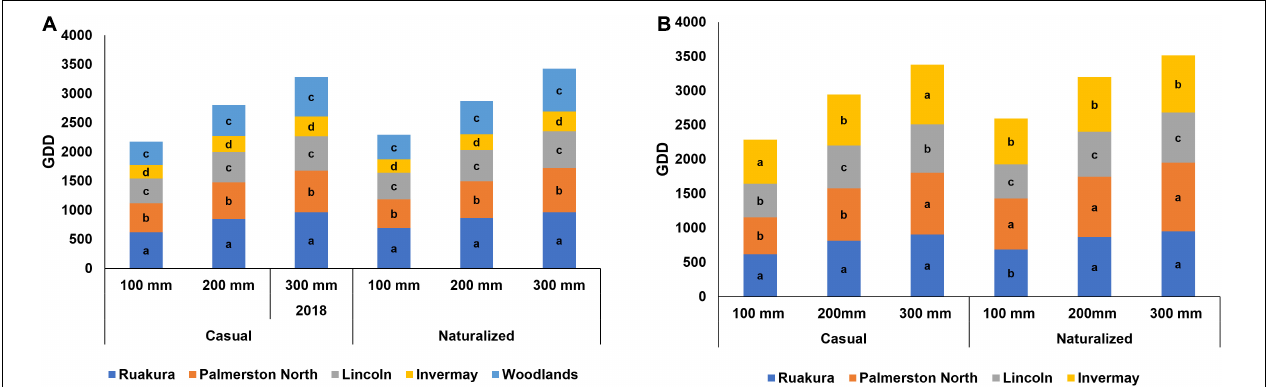
FIGURE 2 | Accumulated growing degree days (GDD) required by the casual and naturalized populations of A. theophrasti in five different regions of New Zealand to reach heights of 100, 200, and 300 mm in the first (A) and second (B) experiments. In the second experiment, plants in Woodlands died after emergence. Within each graph, different letters denote significant ( P < 0.05) differences between locations.